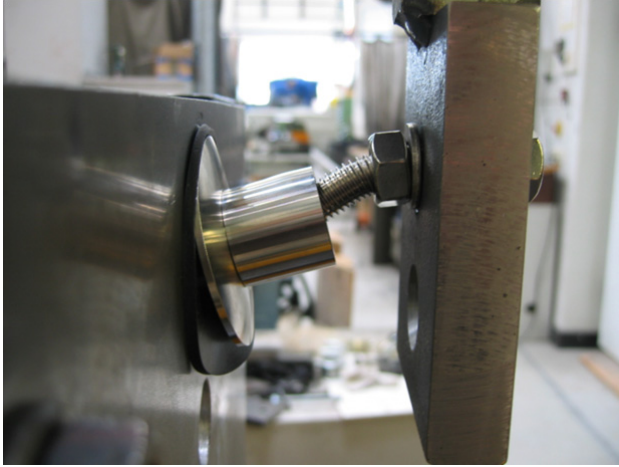
Fig. 2 Comparison of linear and nonlinear